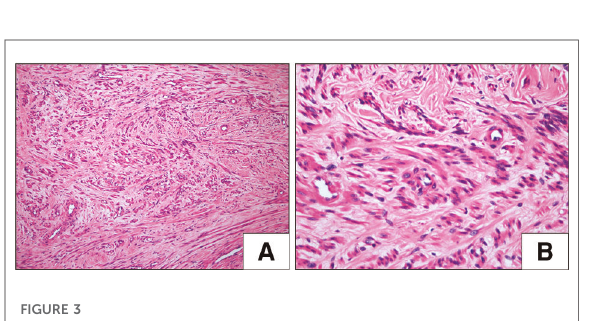
FIGURE 3 Histological examination (HE) of metastasizing leiomyoma. ( A,B ) The spindle cell tumor showed clear boundaries, mild cell morphology, fascicular arrangement, and no mitotic fi gures (H&E staining, A : ×100, B : ×400).